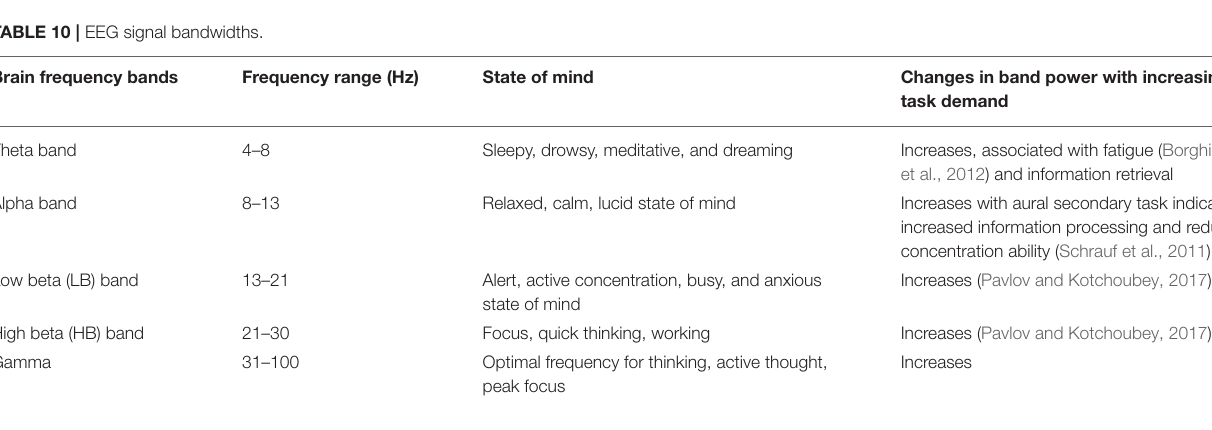
TABLE 10 | EEG signal